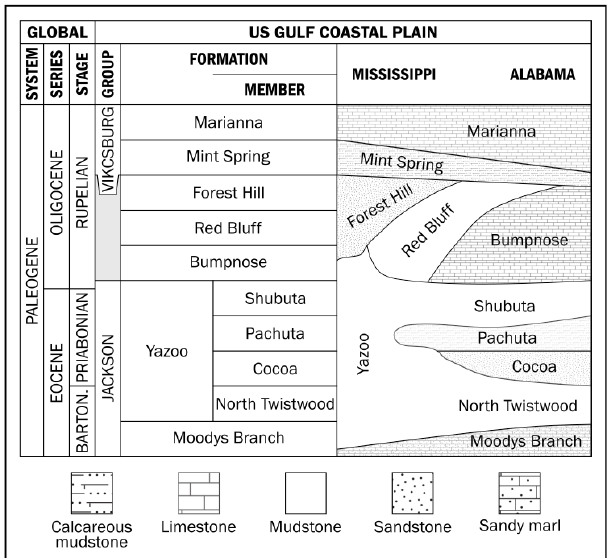
Figure 2. Simplified stratigraphic correlation chart of upper Eocene to lower Oligocene sedimentary rocks in the Mississippi–Alabama area (modified from Pasley and Hazel, 1995; Tew and Mancini, 1995; Hosman,